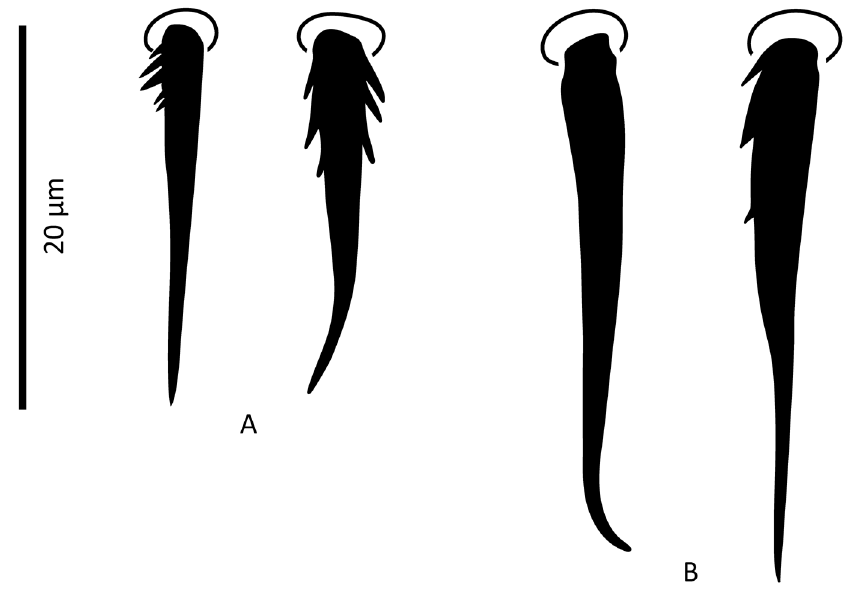
Figure 3. Zygoseius papaver sp. n., female, A seta J5 B seta J4 .